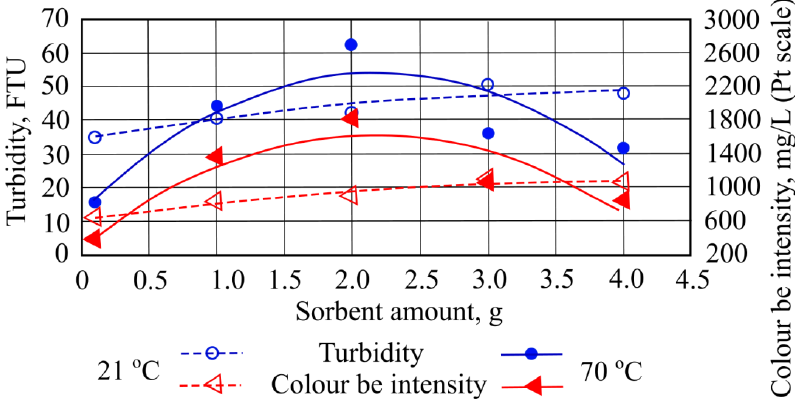
Figure 2. Turbidity values and color intensity when different quantities of straw sorbent are added to the wastewater.